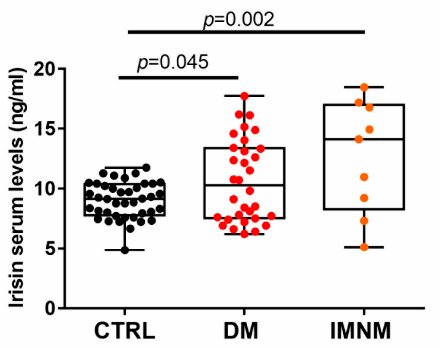
Figure 3. Irisin serum levels (ng/mL) were significantly higher in both DM and IMNM patients compared to control subjects. D’Agostino and Pearson normality test and one-way analysis of variance (ANOVA) with the Tukey’s multiple comparisons test were performed. Data are presented as box-and-whisker plot with median and interquartile ranges from max to min with all data points shown; significant results were indicated by p value.